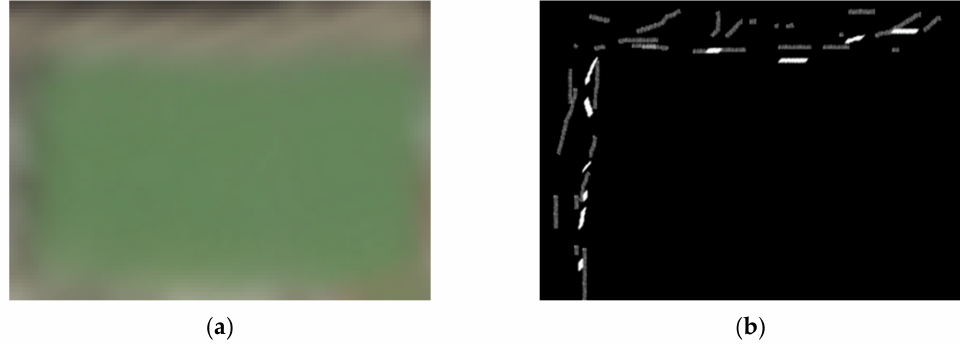
Figure 18. Detected Roof ( a ) Roof Original Image, ( b ) Features Detected by the Convolution Layer. These detected roof data are used as learning data or as data for